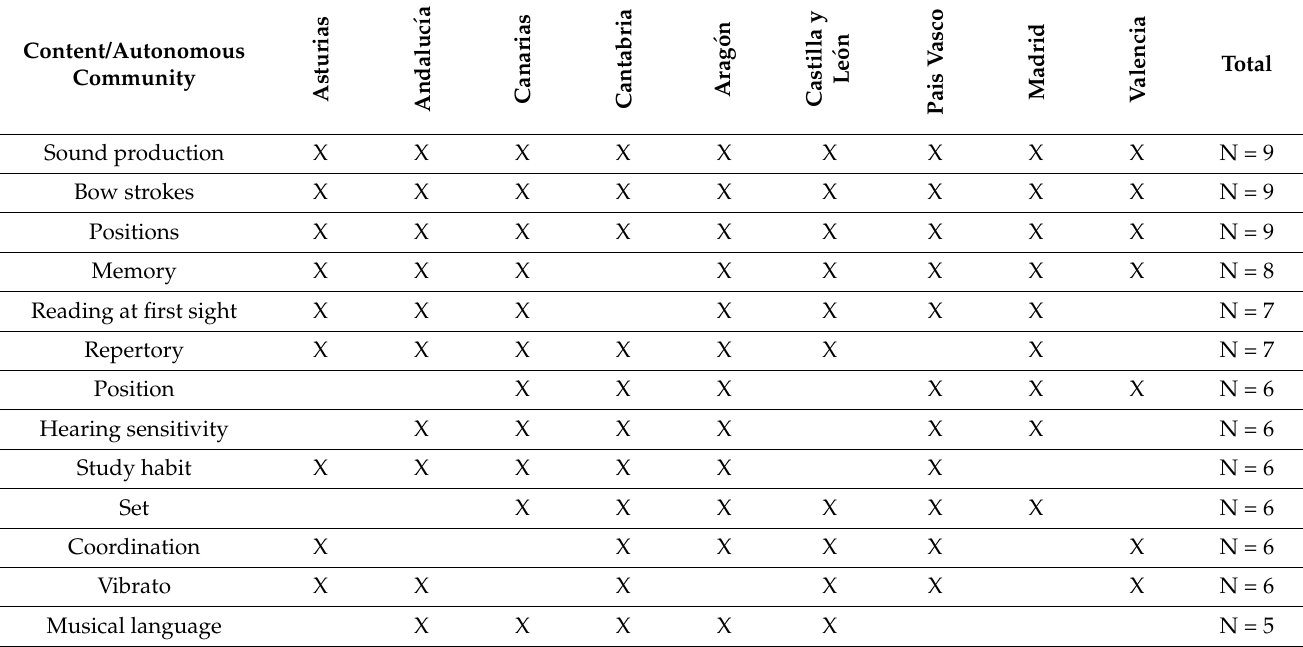
Table 4. Centers involved in research .